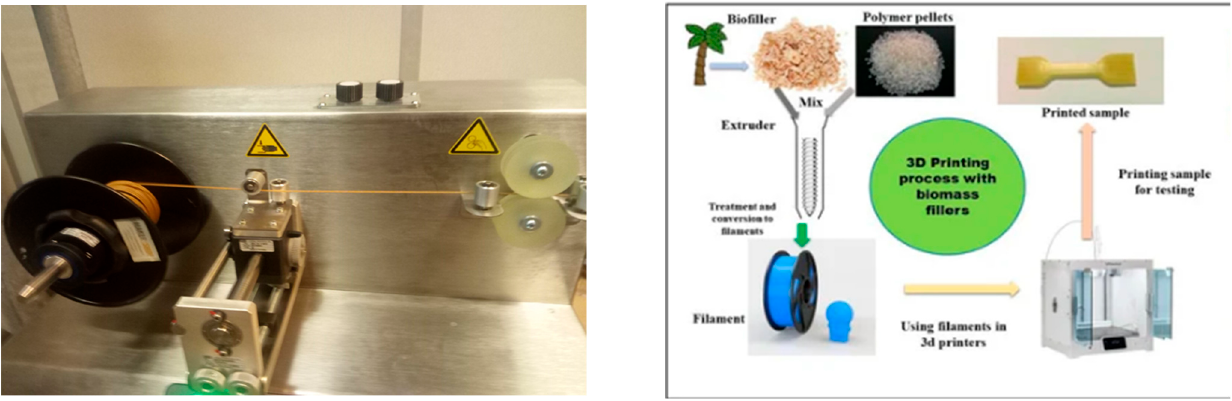
Figure 1. Schematic representation of a typical fused deposition modelling (FDM) device. Extrusion and Printing Conditions in Tables 1 and 2. Table 1. Temperature of the different zones of the extruder and speed of rotation of the screw and collection of the filament.